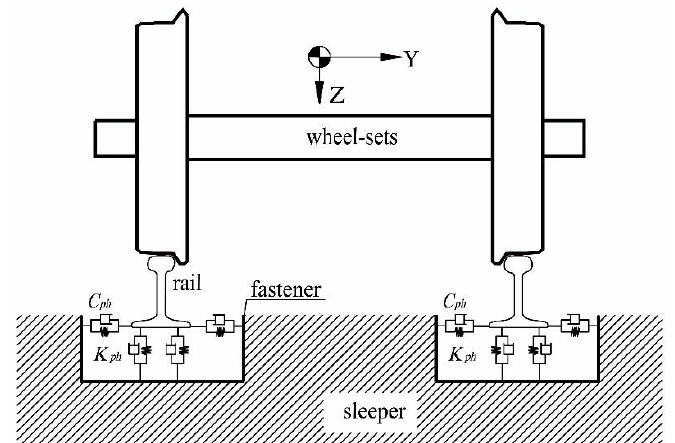
Figure 3. Model of Figure 3. Model of track.